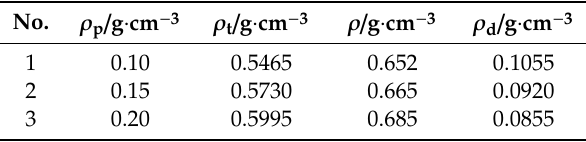
Table 1. Densities of the polyurethane composites.